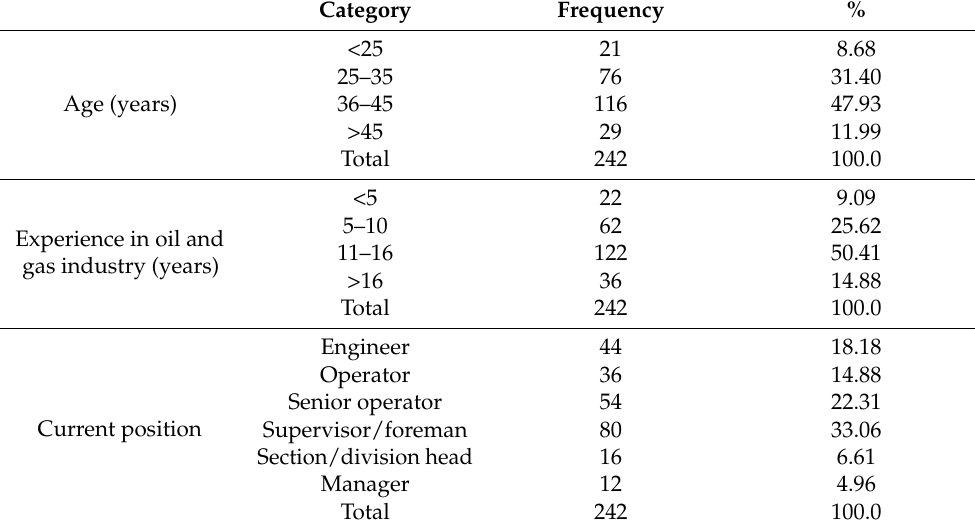
Table 1. Respondents’